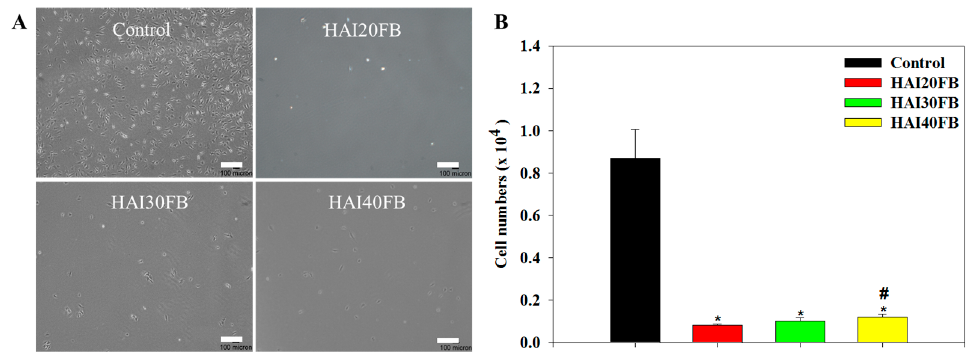
Figure 6. Migration of 3T3 fibroblasts through the control (no NFMs), HAI20FB, HAI30FB or HAI40FB NFMs in 24 h via optical microscopic observation of penetrated cells ( A ) and an assay of penetrated cell numbers ( B ). Bar = 100 µ m. * p < 0.05 compared with control; # p < 0.05 compared with HAI20FB.